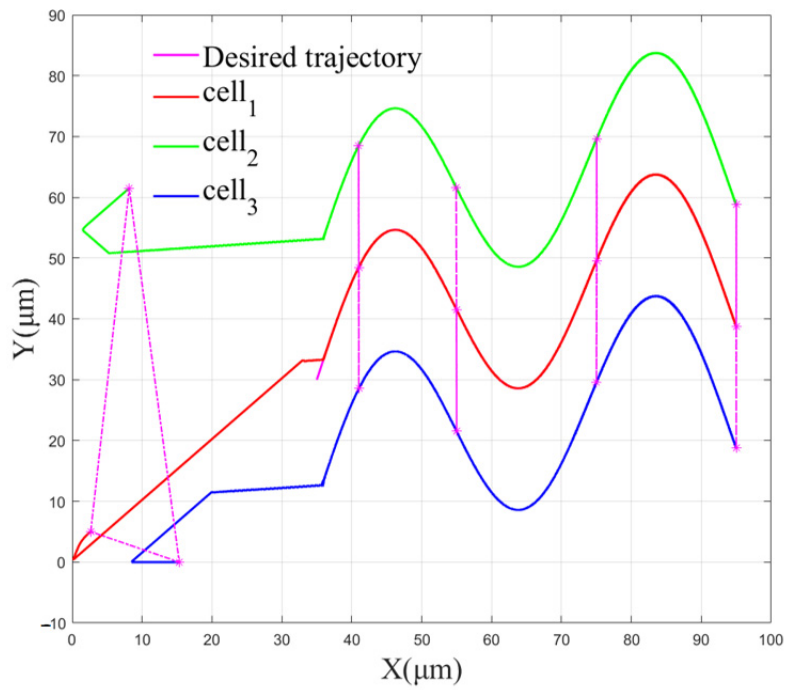
Figure 10. The effect of multi-cell cooperative control.